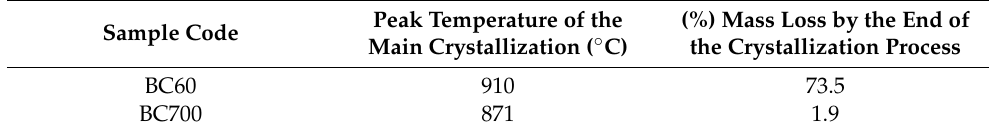
Table 5. Crystallization temperatures and mass loss (in %) at the main crystallization temperature. Peak Temperature of the (%) Mass Loss by the End of Sample Code Main Crystallization ( ◦ C) the Crystallization Process BC60 910 73.5 BC700 871